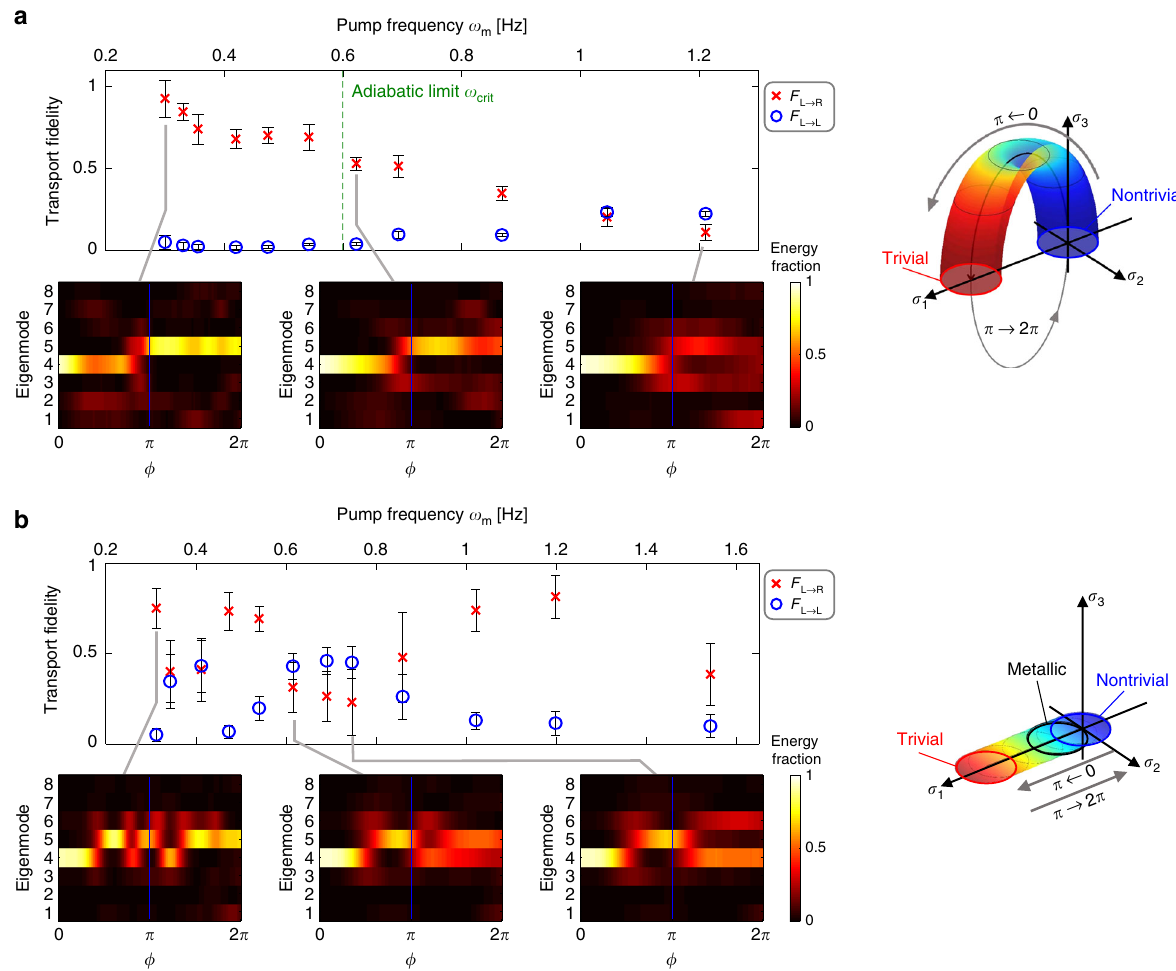
Fig. 3 Experimental measurement of transport fi delity and exploration of the adiabatic regime. a We experimentally tested a range of pump frequencies ω ω ω fi delity F ω ω ω L → R remains high, and diminishes for m traversing the critical threshold crit . For m < crit the transport m > crit . Each data point corresponds to the average of fi delity measurements from 10 consecutive pumping experiments and error bars show the standard deviation between experiments. The insets show representative temporal heat maps of the energy fraction of each basis mode in Fig. 2f. In the adiabatic regime, mechanical energy robustly transports from mode 4 (left edge) to mode 5 (right edge), while in the non-adiabatic regime the energy disperses amongst the bulk modes. The Pauli matrix basis representation of the pumping Hamiltonian is presented on the right, and shows how the Hamiltonian evolves during the pumping cycle between non-trivial and trivial phases while avoiding closing the band gap. b We also tested the non-adiabatic case where band gap closes twice during the cycle, as shown by the Pauli matrix basis representation on the right. In this case the Chern number cannot be used to characterize the process. Mechanical energy is seen to oscillate between the two edge modes, and therefore energy transfer is strongly dependent on timing. Supporting simulations for both cases are provided in Supplementary Note